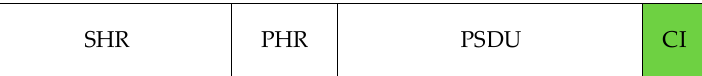
Figure 4. Modified ACK frame format.